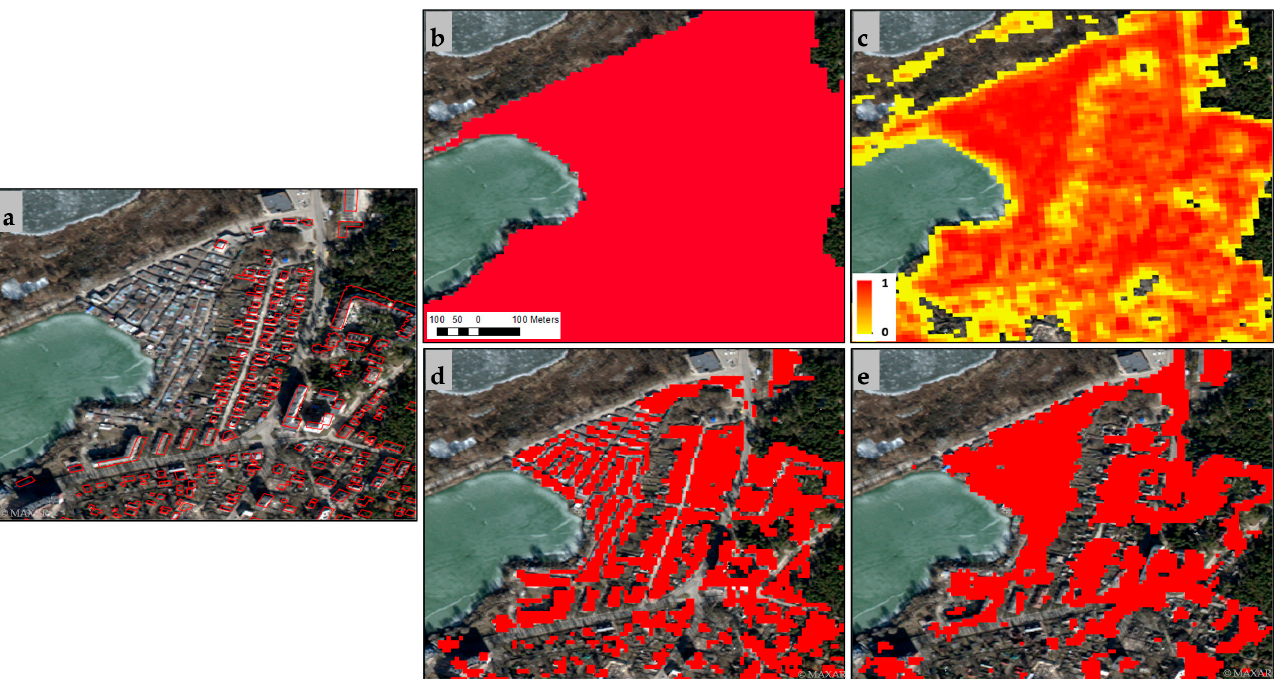
Figure 2. UNOSAT damage assessment map of Bucha city. The background image is from Sentinel-2 acquired on 2 January 2022. The red rectangular box denotes the area shown in Figure 3, and the orange rectangular box shows the AOI for threshold selec- tion.